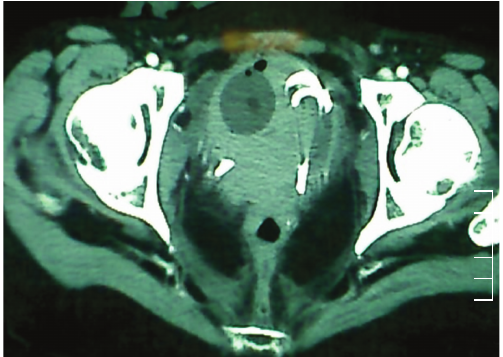
Figure 1: CT scan demonstrating bladder completely filled with blood clots, catheter balloon, and ureteral stents.